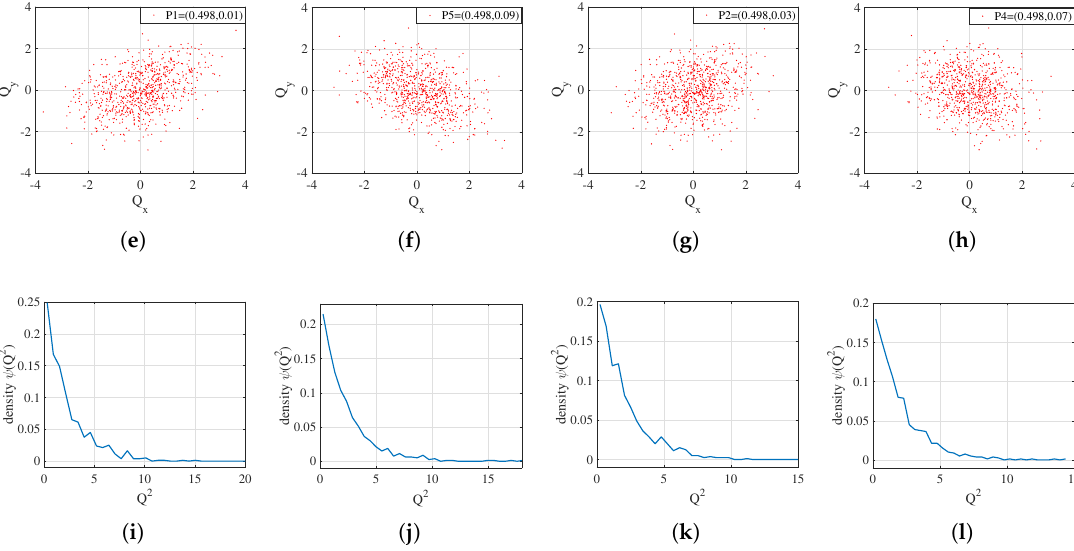
Figure 15. ( a ) Stress component τ xx on the y -axis; ( b ) stretch length D on the y -axis; ( c ) the distribution of molecules Q 3 at point P 3 = ( 0.498,0.05 ) ; ( d ) corresponding probability density function (pdf) at point P 3 = ( 0.498,0.05 ) ; ( e ) the distribution of molecules Q 1 at point P 1 = ( 0.498,0.01 ) ; ( f ) the distribution of molecules Q 5 at point P 5 = ( 0.498,0.09 ) ; ( g ) the distribution of molecules Q 2 at point P 2 = ( 0.498,0.03 ) ; ( h ) the distribution of molecules Q 4 at point P 4 = ( 0.498,0.07 ) ; ( i ) corresponding probability density function (pdf) at point P 1 = ( 0.498,0.01 ) ; ( j ) corresponding probability density function (pdf) at point P 5 = ( 0.498,0.09 ) ; ( k ) corresponding probability density function (pdf) at point P 2 = ( 0.498,0.03 ) ; and ( l ) corresponding probability density function (pdf) at point P 4 = ( 0.498,0.07 )